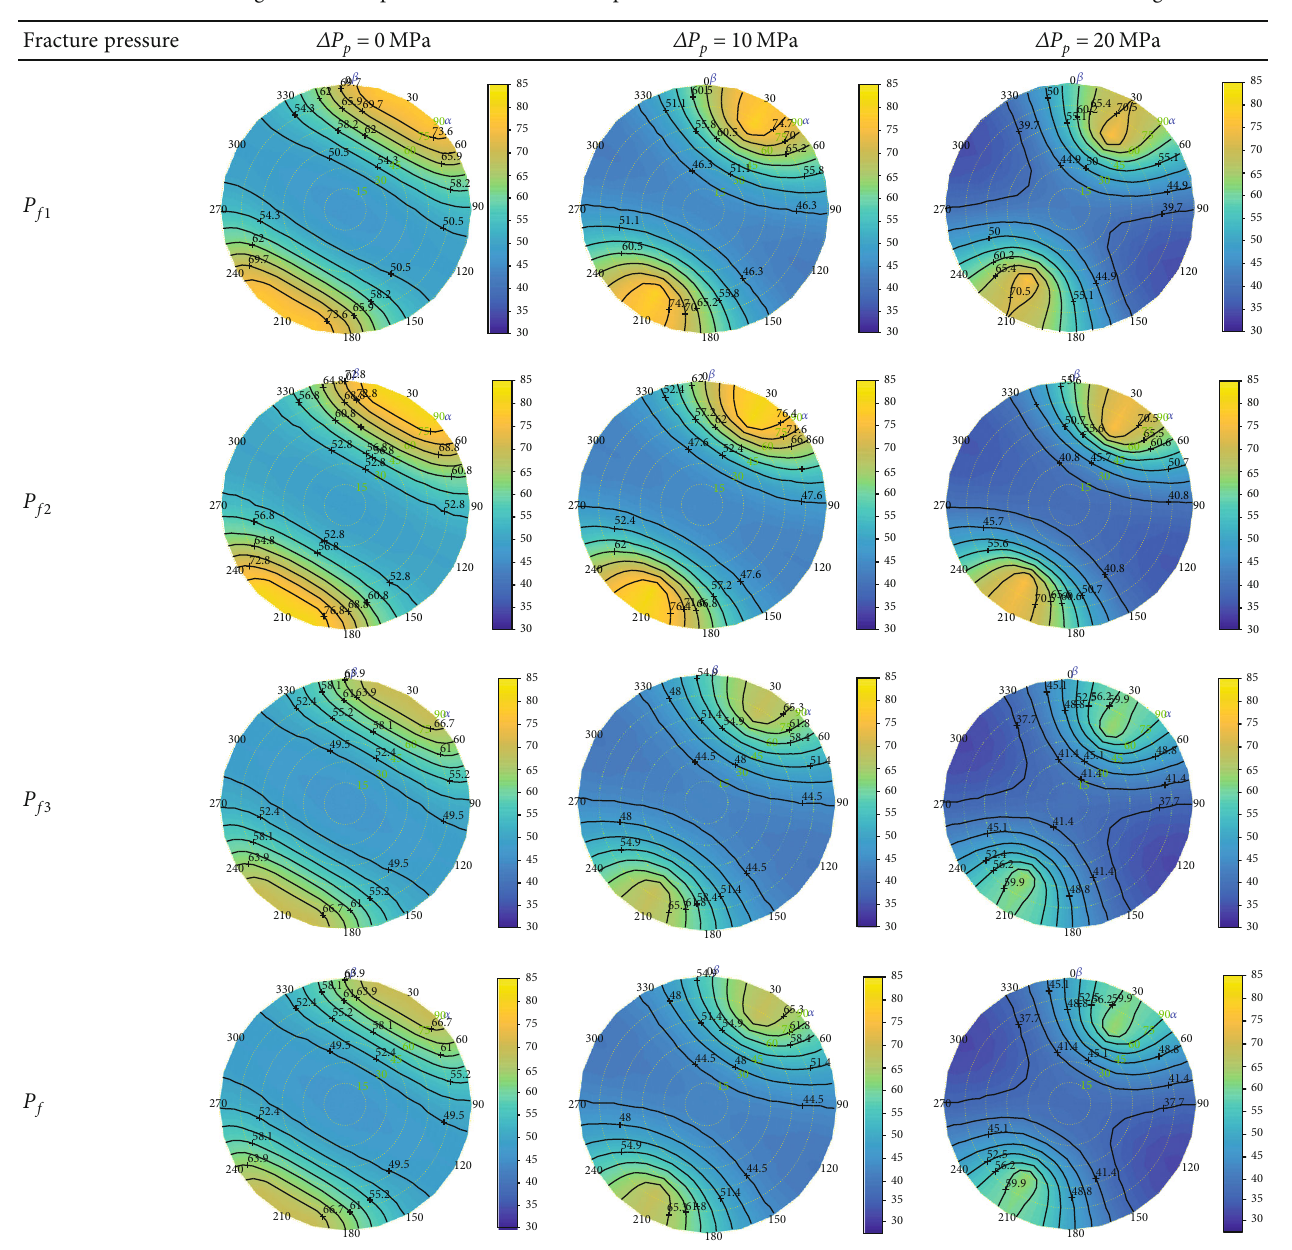
Table 4: The change of fracture pressure with reservoir depletion of directional wellbore drilled in strike fault stress regime. Fracture pressure Δ P p = 0MPa Δ P p = 10 MPa Δ P p = 20MPa